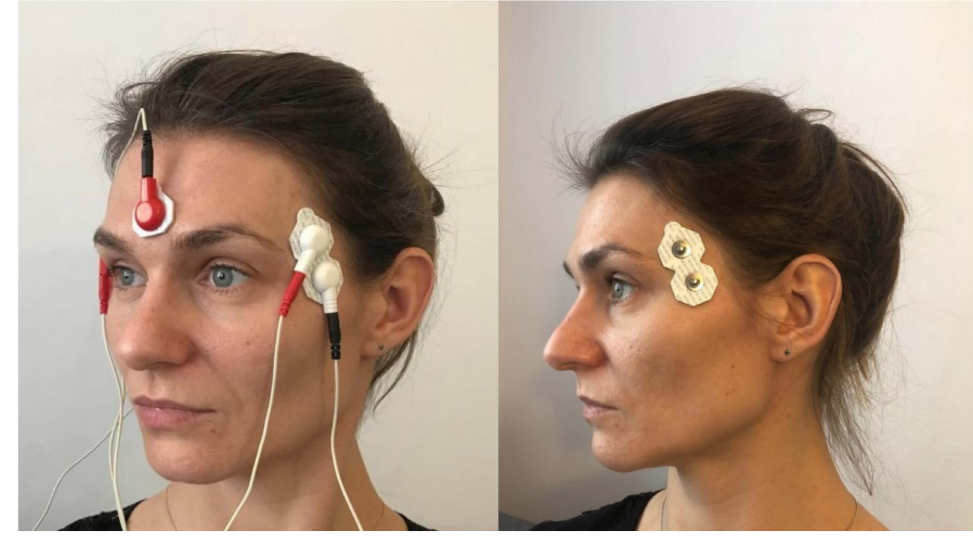
Figure 1. Location of surface electrodes on the front of the temporal muscle. (Own material).